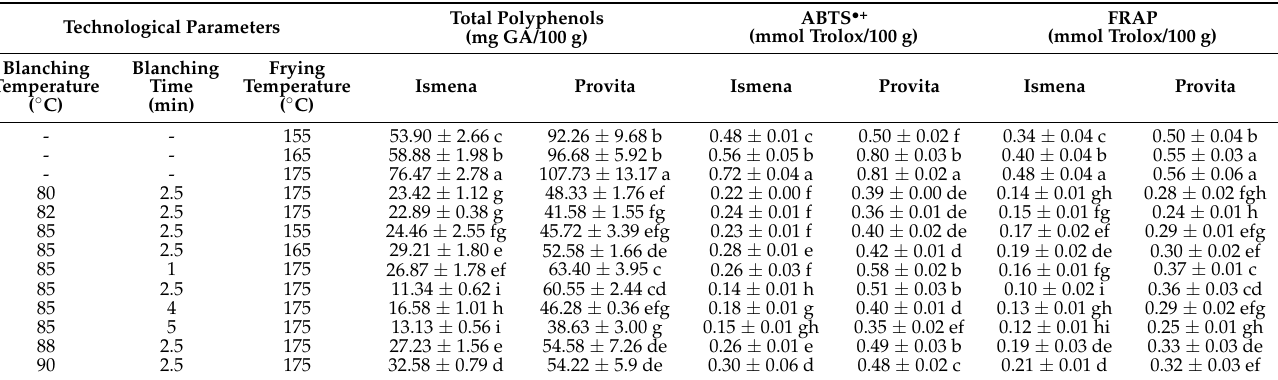
Table 5. Total polyphenol content and antioxidant activity in potato crisps, depending on technologi- cal